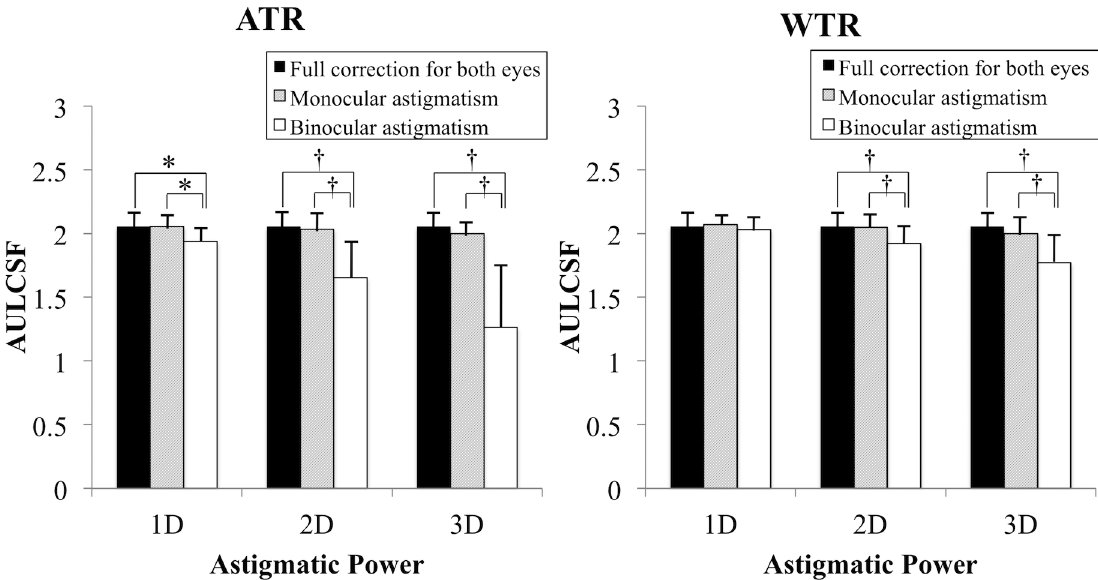
Fig 3. Comparison of area under the log contrast sensitivity function (AULCSF) among three astigmatic conditions. In against-the- rule (ATR) astigmatic defocus or +2.00 D and +3.00 D with-the-rule (WTR) astigmatic defocus, AULCSF under binocular astigmatic conditions was significantly worse than that under other astigmatic conditions. ( (cid:3) P < 0.05; †P < 0.01, Fisher’s protected least-significant